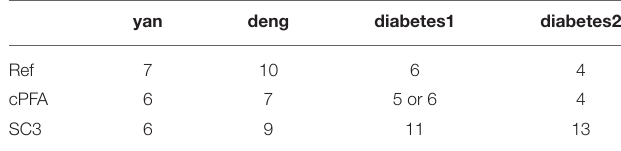
repeated 50 times under different systematic conditions (e.g., TABLE 1 | The estimation of K compared with SC3 on real datasets.